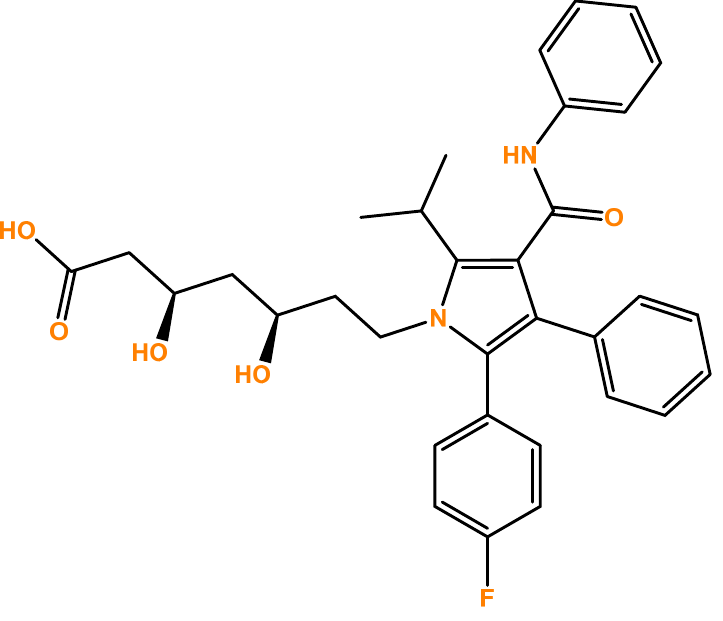
Figure 1. Chemical structure of Atorvastatin.